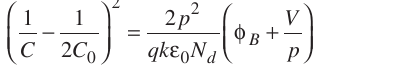
O additive, 6 11